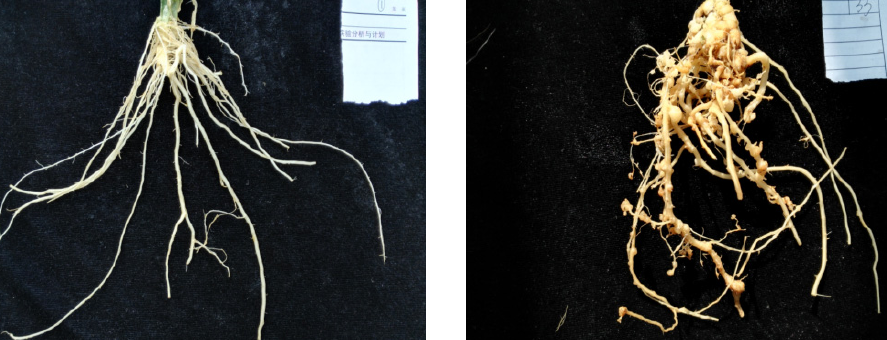
Figure 1. The captured cucumber root images.